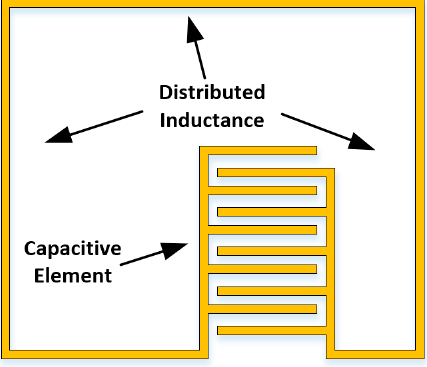
Figure 10. Single Plane Stretchable Resonator Sensor—Adapted from Reference [172].